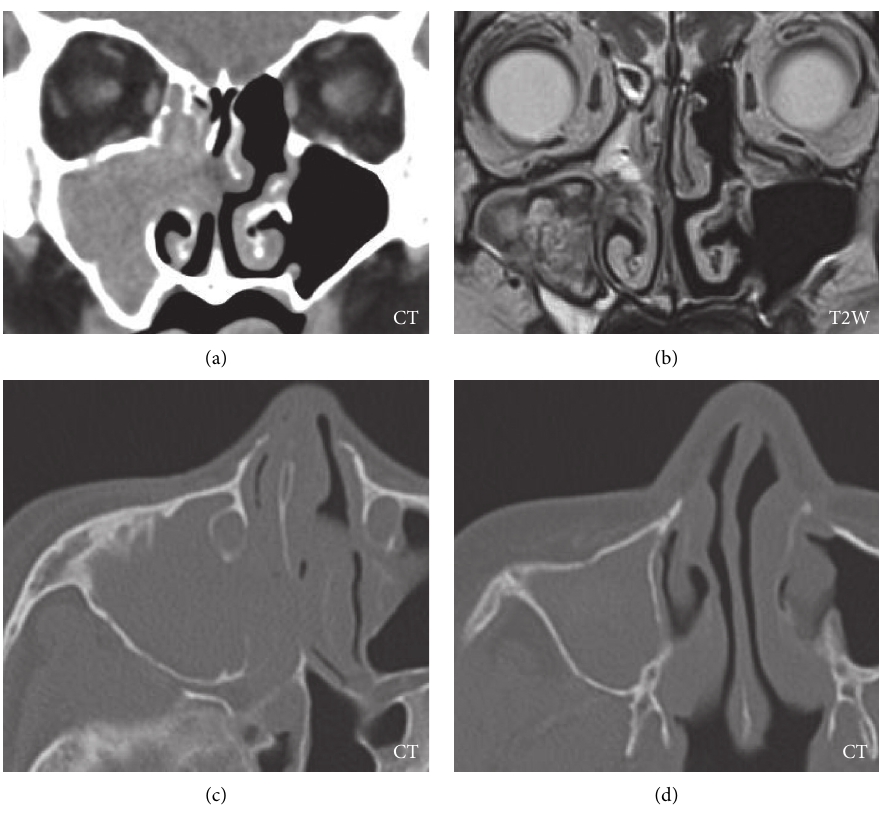
Figure 1: Initial images. CT: shadow of the soft-tissue density of the right maxillary sinus; T2W: well-circumscribed, smoothly marginated tumor with a peripheral low area and a central inhomogeneous area.